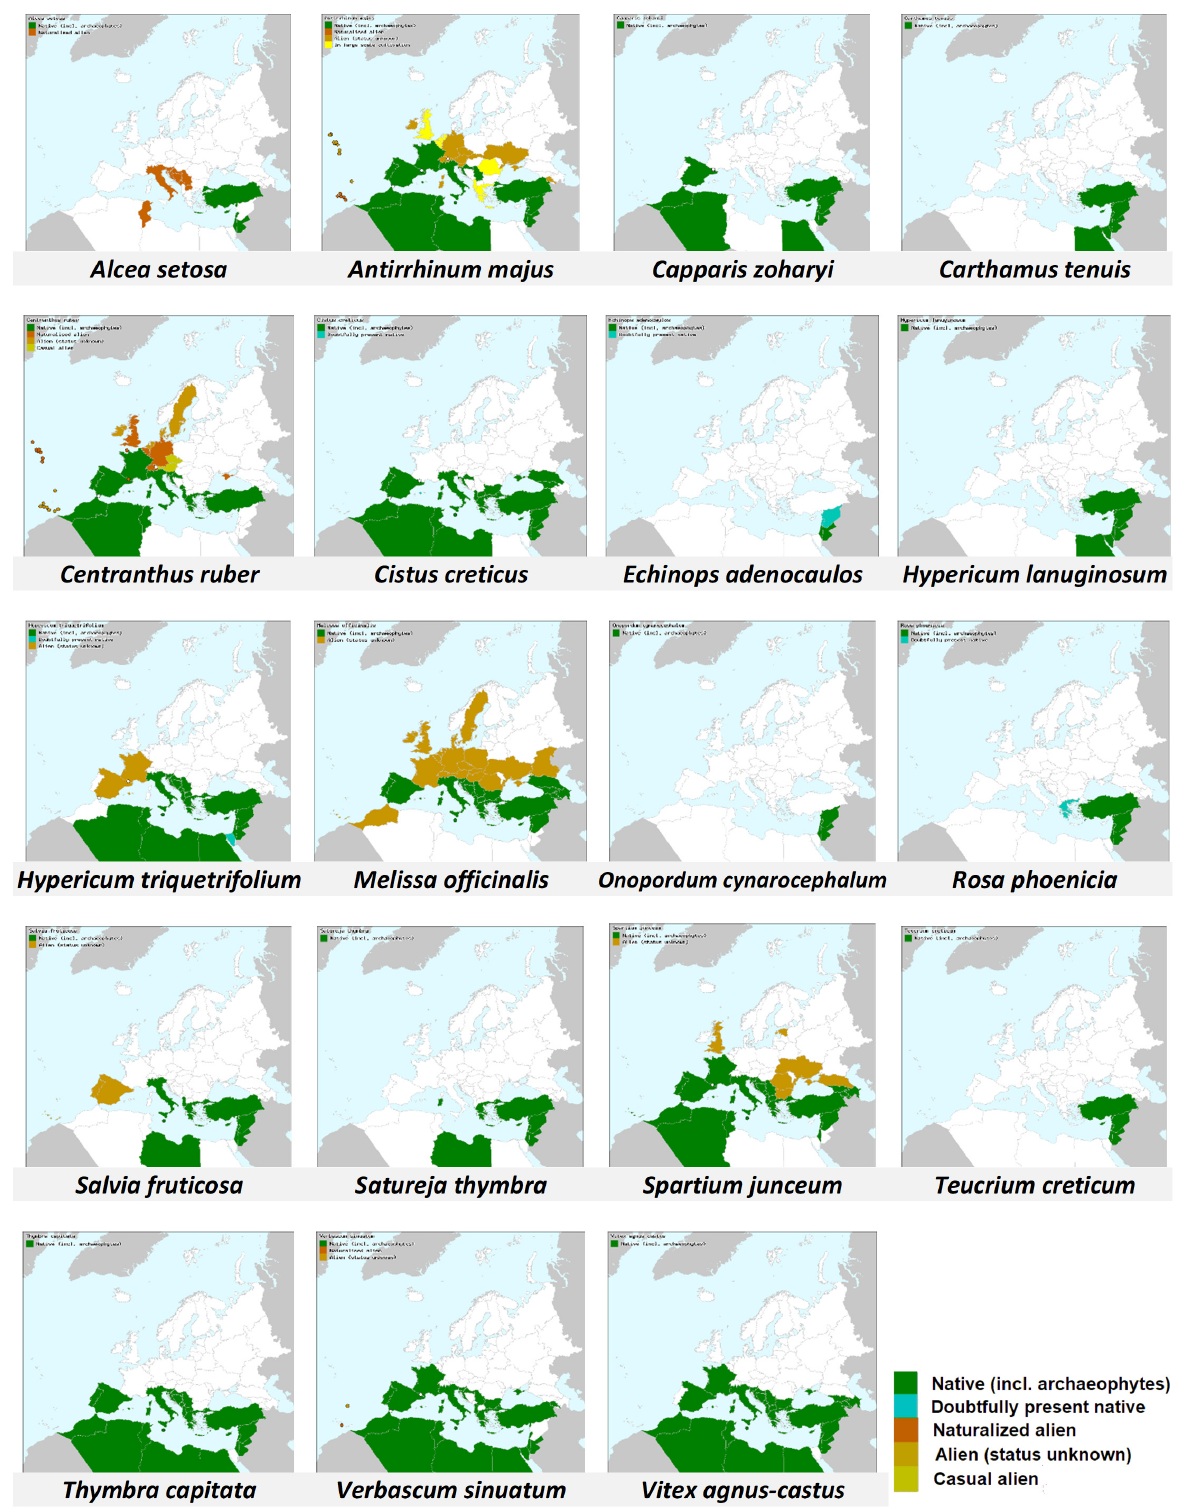
Figure 7. Distribution in Europe and the Mediterranean basin (color filling by countries) of the plant species visited by B. terrestris at the Soreq site in our study. Map source: Euro+Med (2006). Dark Green color indicates native